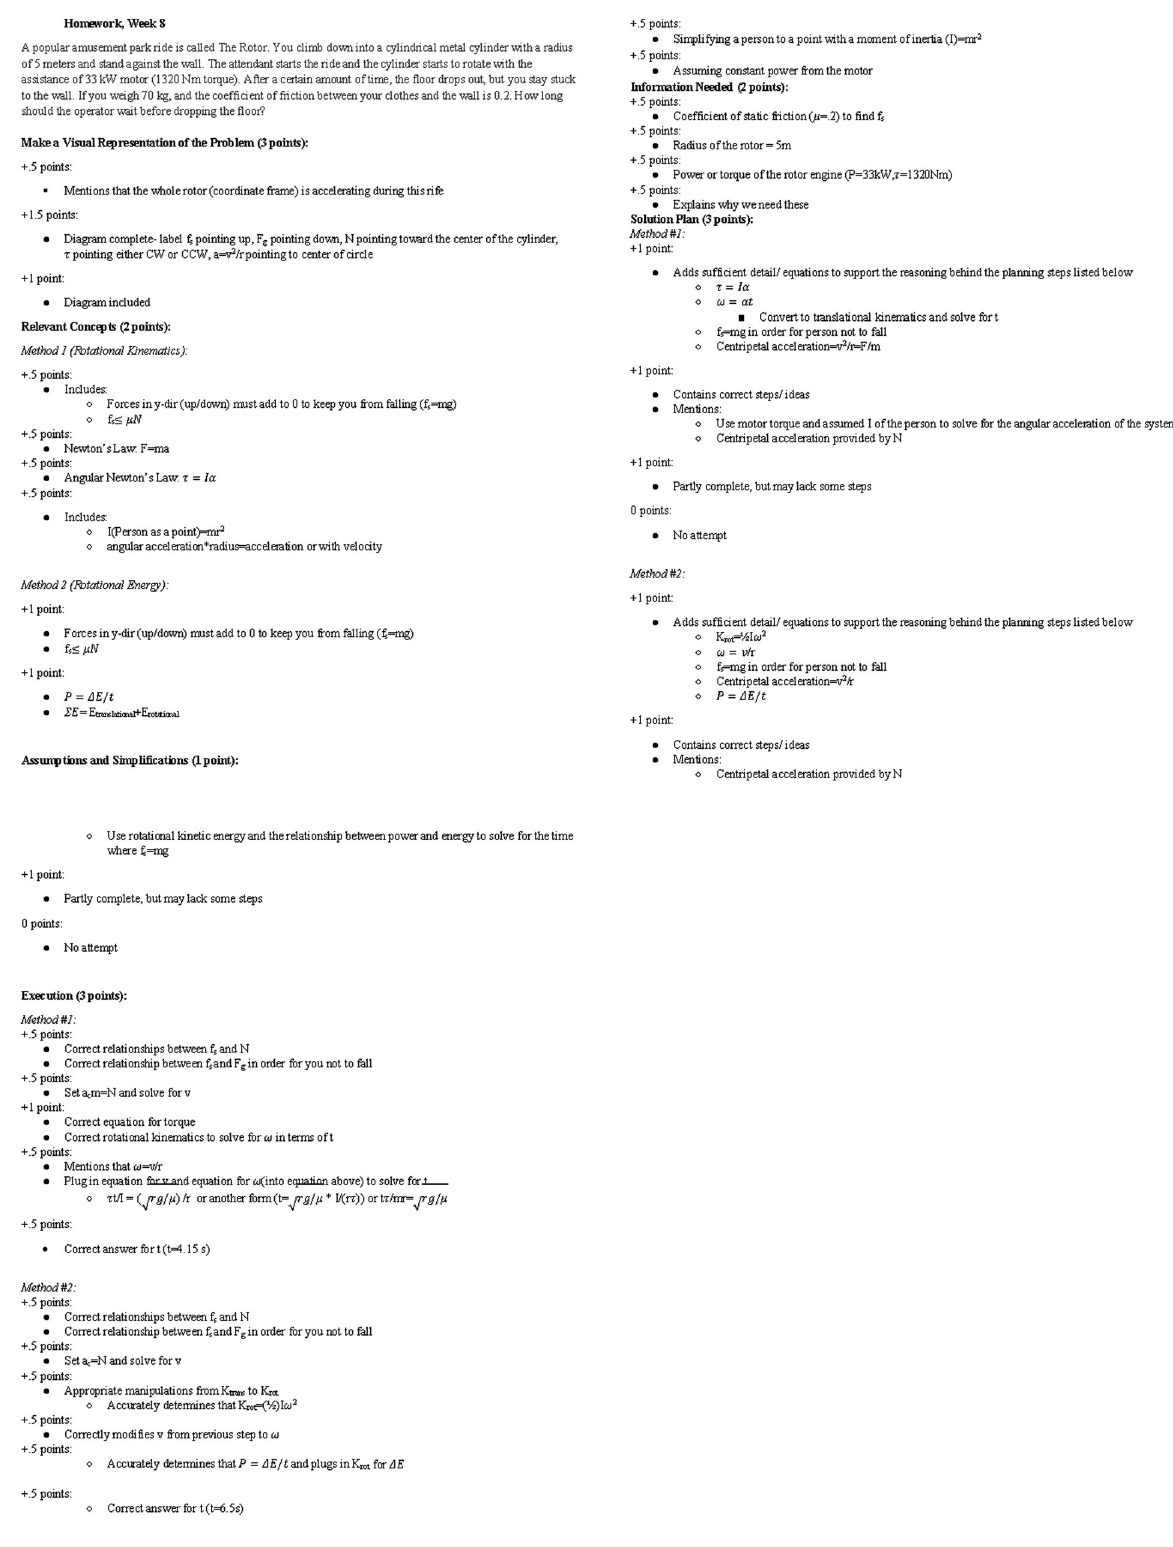
FIG. 12. Rubric for homework, week